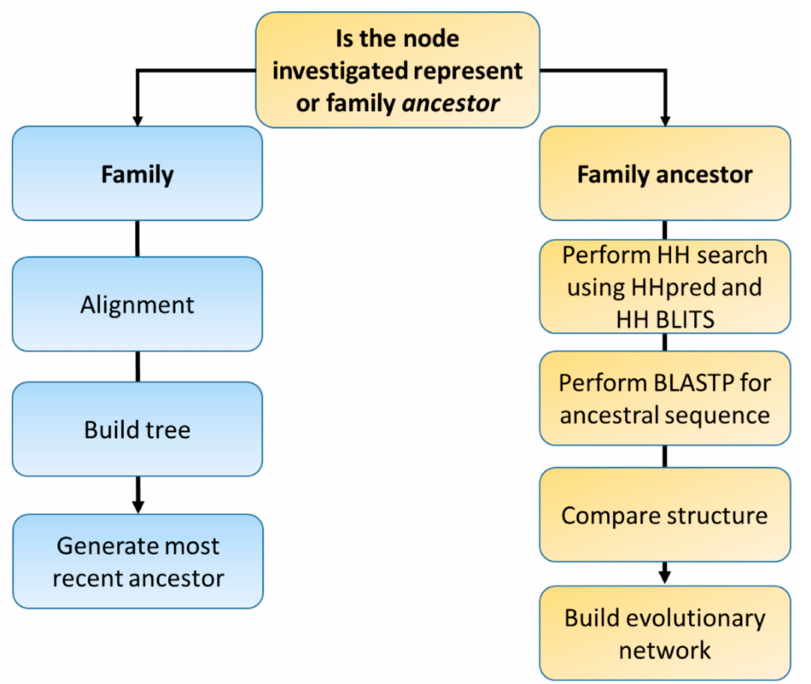
Figure 1. Workflow of the evolutionary analysis of the IL families. Each node was designated as a family or ancestral sequence node. The ancestral sequence for each family was used to generate an ancestral sequence for each superfamily. The ancestral sequence for the superfamily was utilized as an input for homology search. Finally, an evolutionary network was